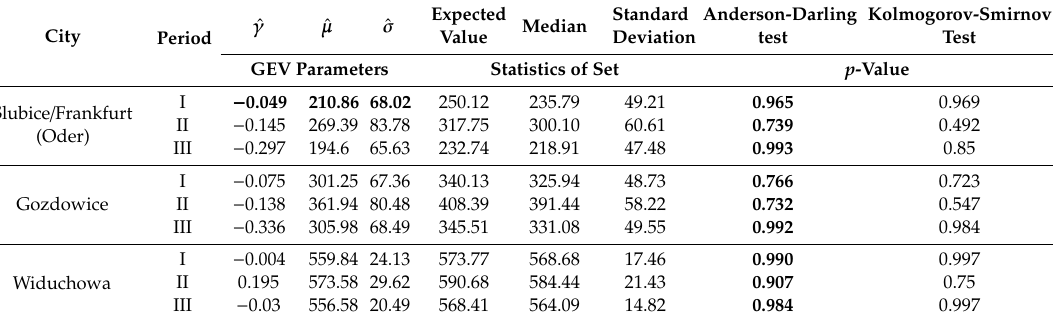
Table 2. Estimator values for parameters of distribution functions G γµ , σ along with compatibility test results.